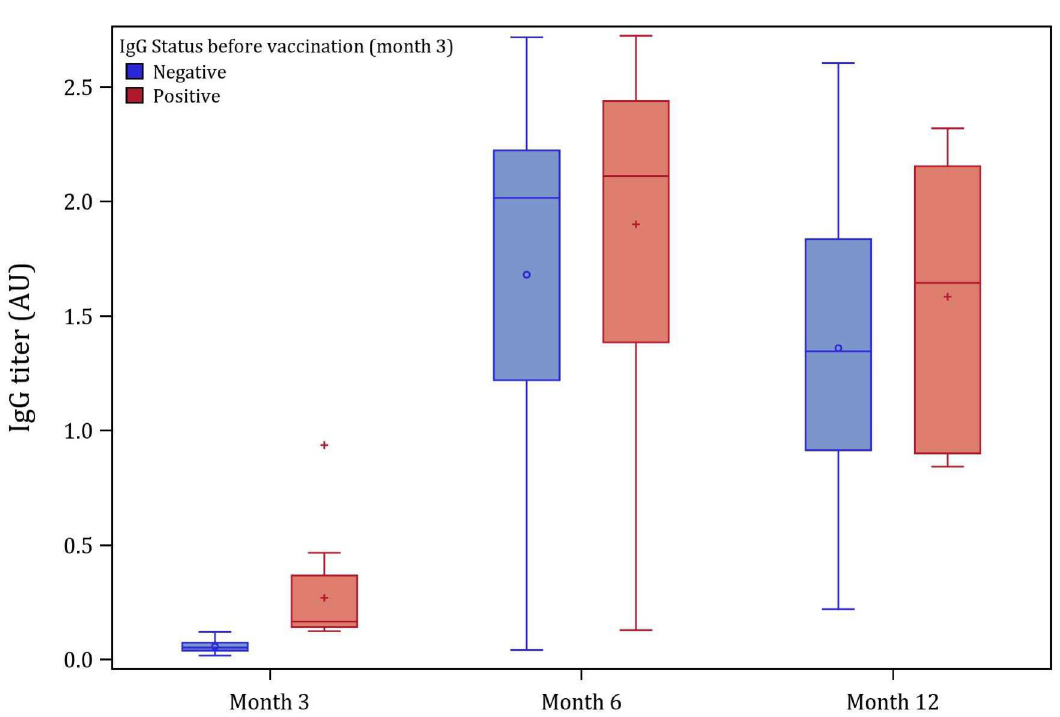
Fig 4. Box plot for participants who got blood tested at months 3, 6 and 12 comparing those spike protein IgG positive at month 3 versus those negative at month 3. Legend: The bottom and top edges of the box indicate the IQR, the marker inside the box indicates the mean value, the line inside the box indicates the median value. The upper and lower fences are maximum and minimum values, respectively, points beyond upper and lower fences are outliers. Red bar are those IgG positive at month 3 and blue bar are those negative at month